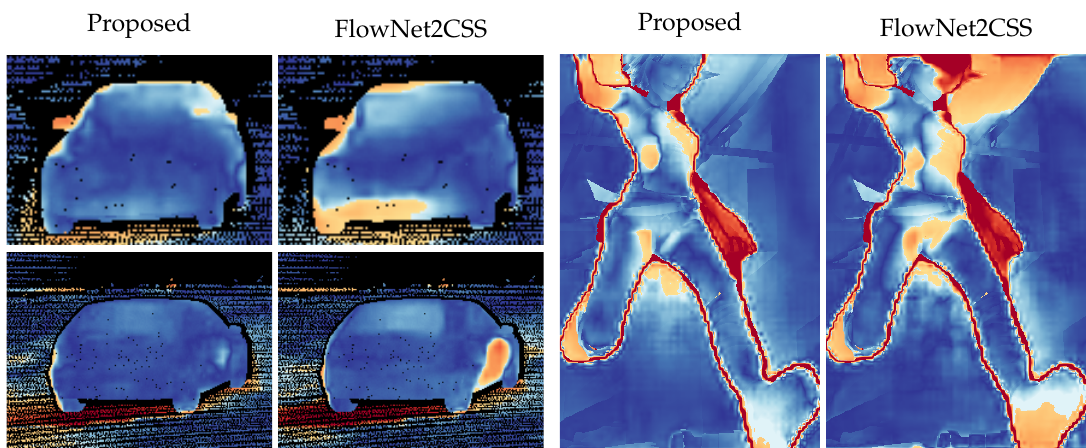
Figure 17. Closeup of differences at object boundaries between errormaps of the proposed method and